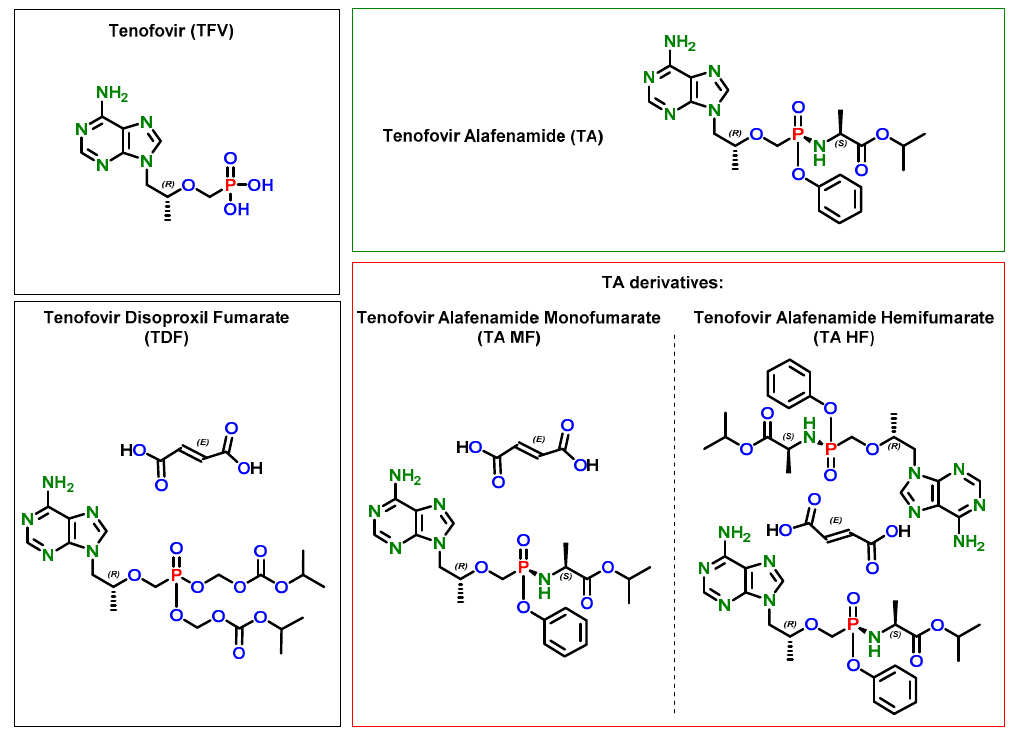
Figure 1. Chemical structure of tenofovir and its prodrug fumarate derivatives.